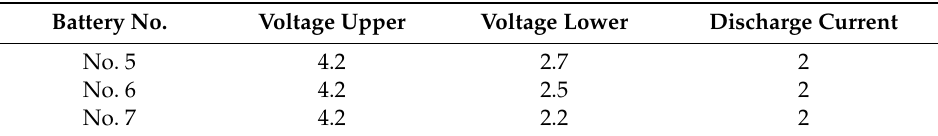
Table 3. Cell Table 3. Cell parameters.